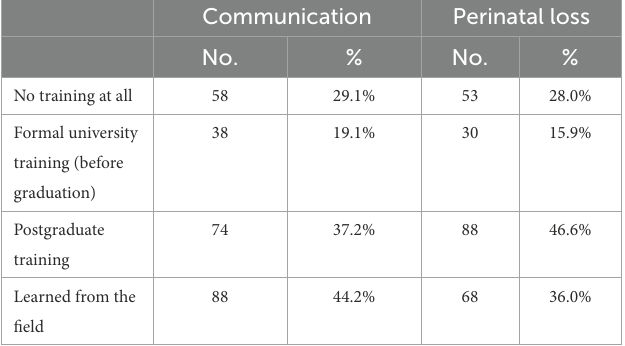
TABLE 3 Previous training in communication and in perinatal